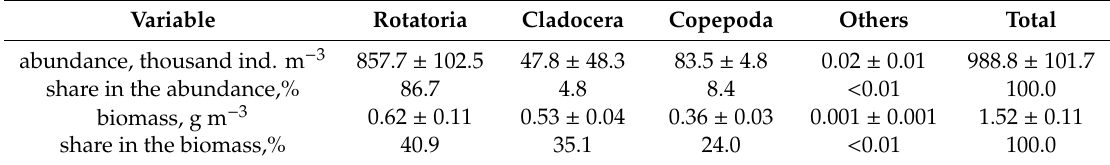
Table 3. Quantitative variables of zooplankton of the Borovoe Lake, 2019 (mean with standard error). Variable Rotatoria Cladocera Copepoda Others Total abundance, thousand ind. m − 3